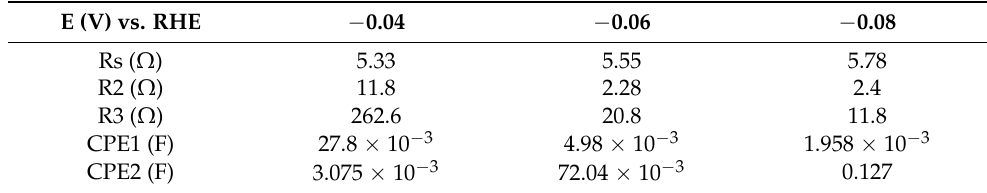
Table 3. The parameters, obtained from EIS data for PtAu/rGO at different applied potentials. E (V) vs. RHE − 0.04